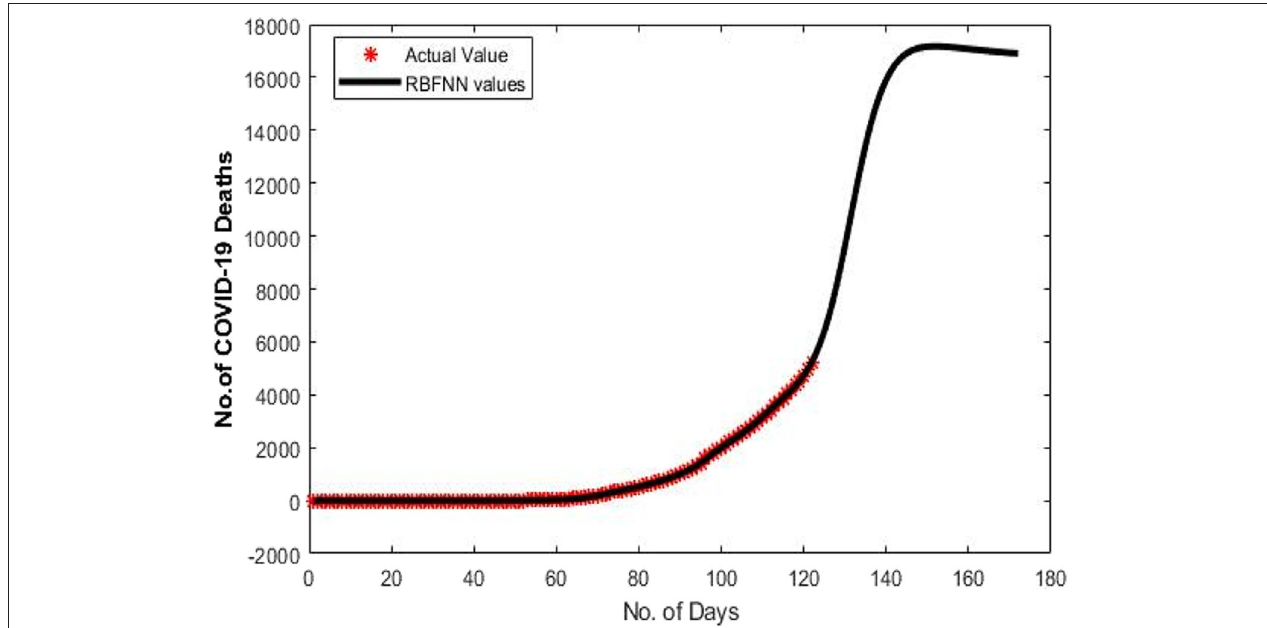
FIGURE 8 | Predicted curve for D1 using RBFNN.